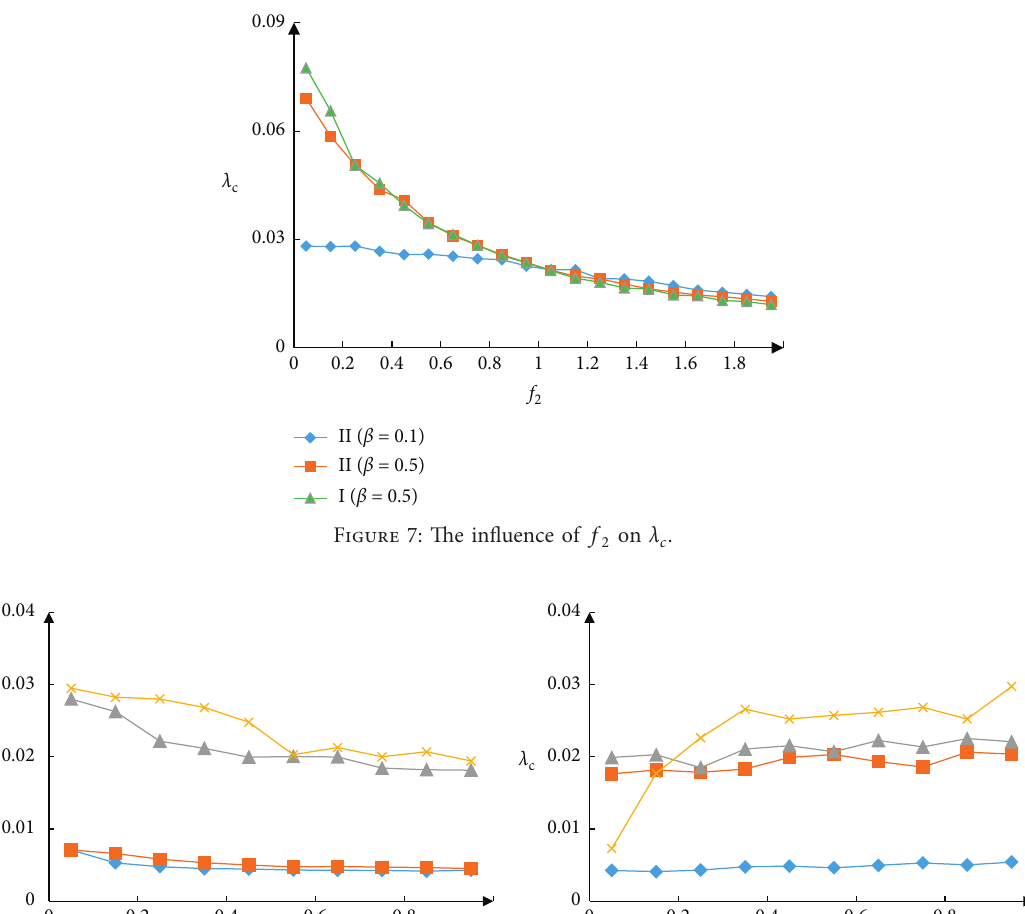
� 0.2, f � 1.8; (b) f c : (a) f 1 2